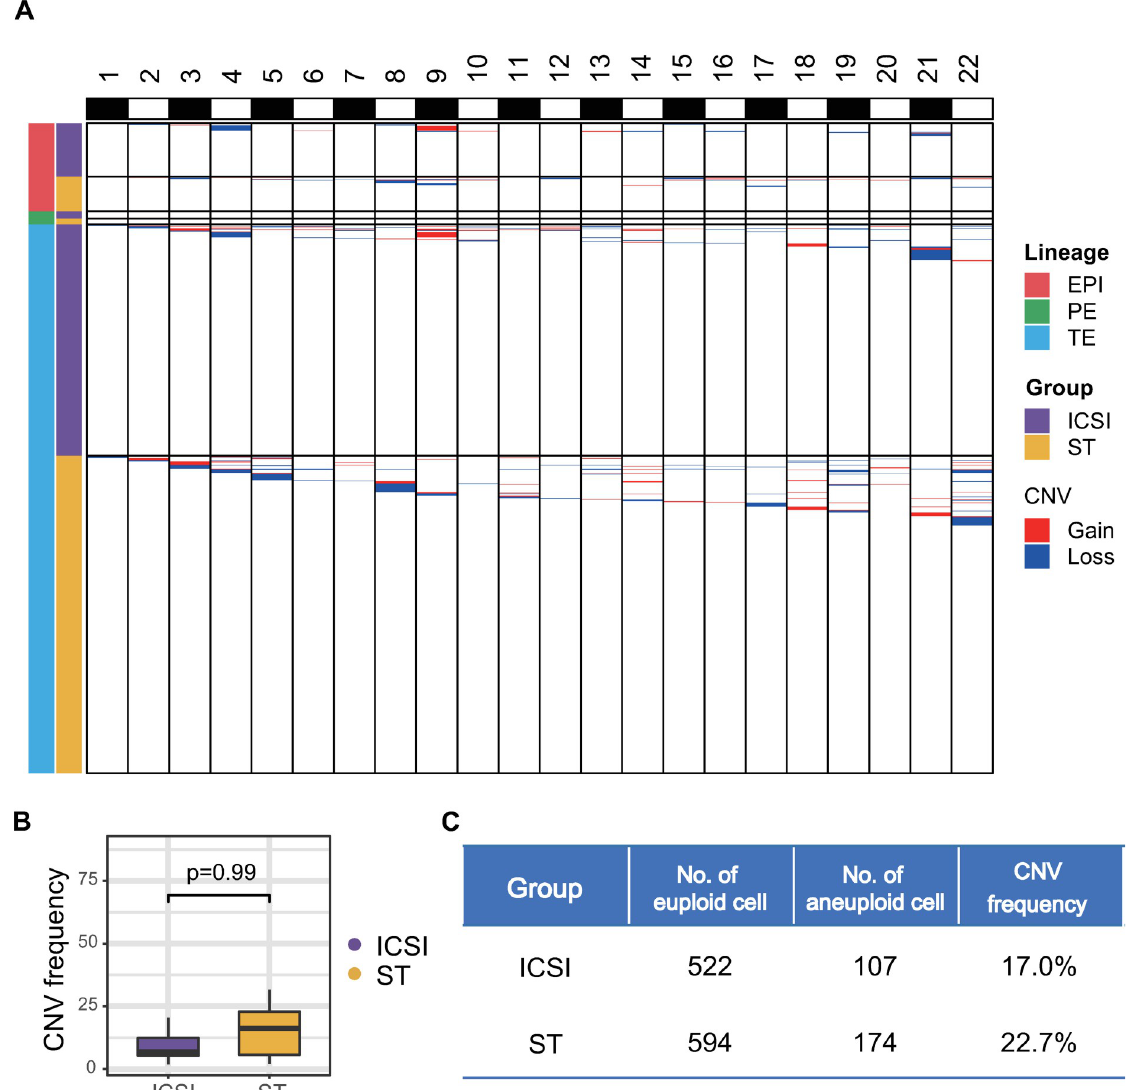
Fig 5. CNV analysis. (A) Global CNV patterns of the 1,397 cells from 45 embryos. (B, C) The CNV frequency for embryos was calculated based on the percentage of aneuploid cells in each embryo and tested by the Wilcoxon sum test (B). The numbers of euploid or aneuploid cells in the ST or ICSI control groups are listed in Table (C). The numerical data are listed in S2 Data. CNV, copy number variation; EPI, epiblast; ICSI, intracytoplasmic sperm injection; PE, primitive endoderm; ST, spindle transfer; TE,